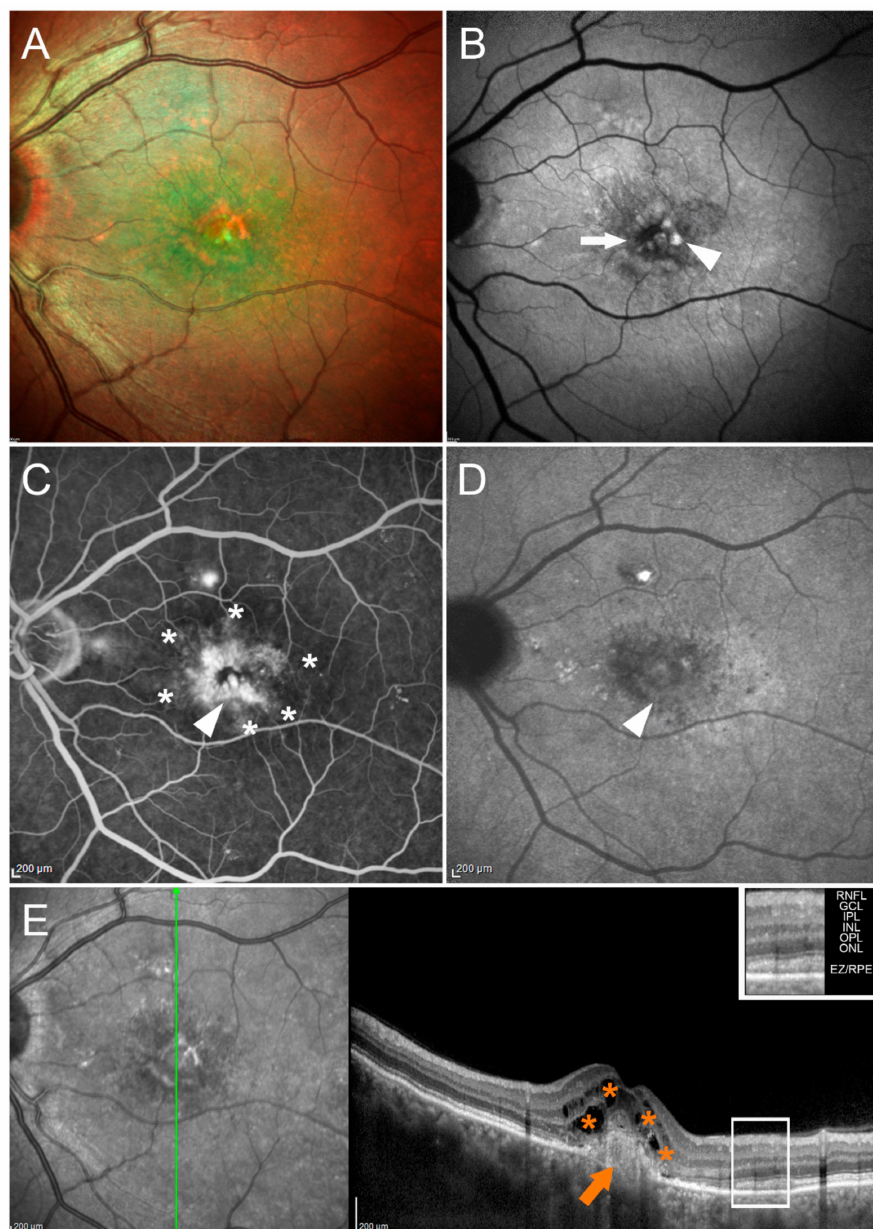
Figure 4. Central serous chorioretinopathy complicated by macular neovascularization. Multicolor ( A ) and BAF ( B ) images show hypoautofluorescent (white arrow) and hyperautofluorescent (white arrowhead) alterations localized in the macular region. FA ( C ) discloses a hyperfluorescent alter- ation (white arrowhead) with perilesional leakage (white asterisks). This corresponds to a mainly hypocyanescent alteration on ICGA (white arrowhead) ( D ). Structural OCT reveals the presence of a hyperreflective subretinal lesion (orange arrow), with smooth exudation in its context and intraretinal cysts (orange asterisks). The OCT layers legend is provided in the upper-right part of the image. The following abbreviations are used: retinal nerve fiber layer (RNFL), ganglion cell layer (GCL), inner plexiform layer (IPL), inner nuclear layer (INL), outer plexiform layer (OPL), outer nuclear layer (ONL), ellipsoid zone/retinal pigment epithelium complex (EZ/RPE) ( E